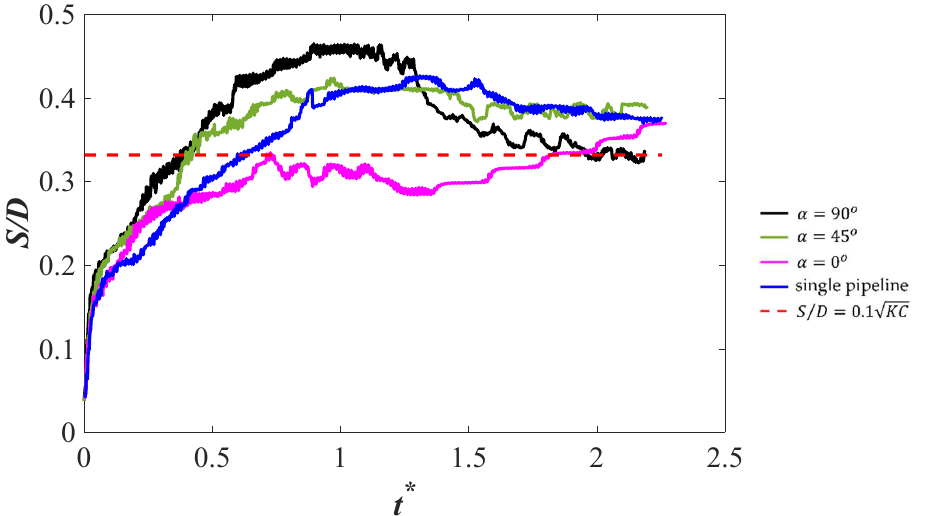
Figure 8. The time histories of nondimensional scour depth for the single pipeline and the piggyback pipelines: α = 90 ◦ : black; α = 45 ◦ : green; α = 0 ◦ : magenta; the single pipeline case: blue.